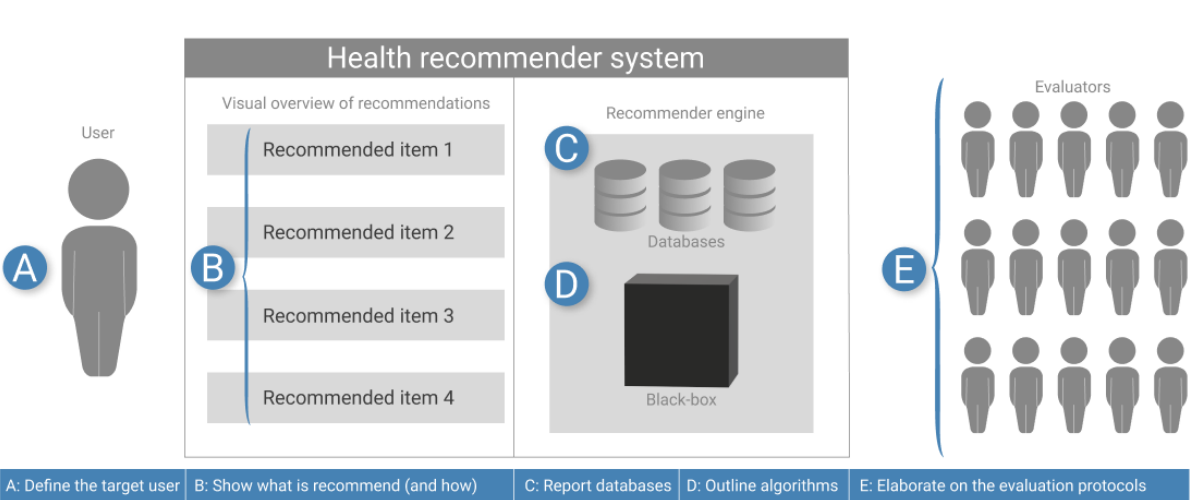
Figure 6. A reference frame to report health recommender system studies. On the basis of the results of this study, we suggest that it should be clear what and how items are recommended (A), who the target user is (B), which data are used (C), and which recommender techniques are applied (D). Finally, the evaluation design should be reported in detail